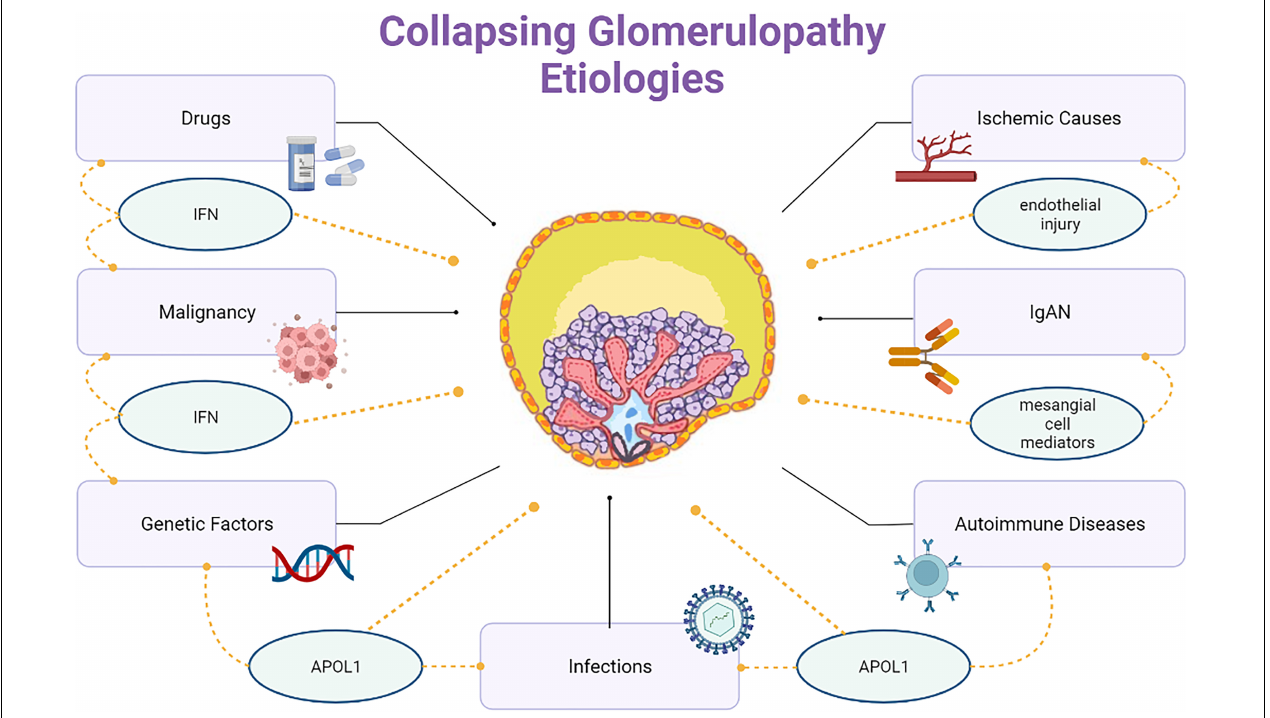
FIGURE 2 | Collapsing glomerulopathy